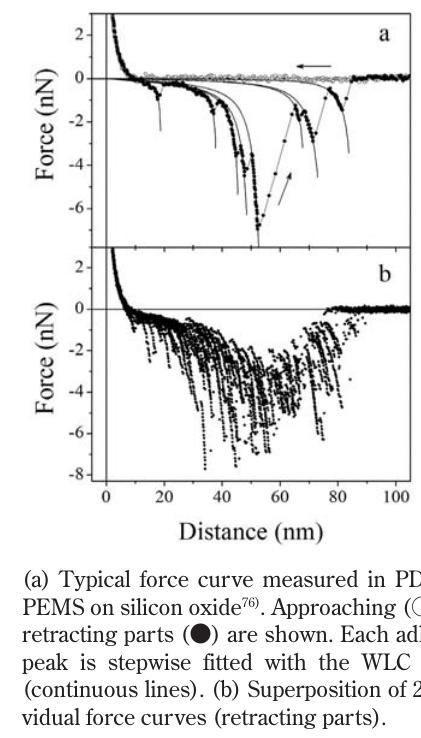
Fig. 7 (a) Typical force curve measured in PDMS-b- PEMS on silicon oxide 76) . Approaching ( ○ ) and retracting parts ( ● ) are shown. Each adhesion peak is stepwise fitted with the WLC model (continuous lines). (b) Superposition of 20 indi- vidual force curves (retracting